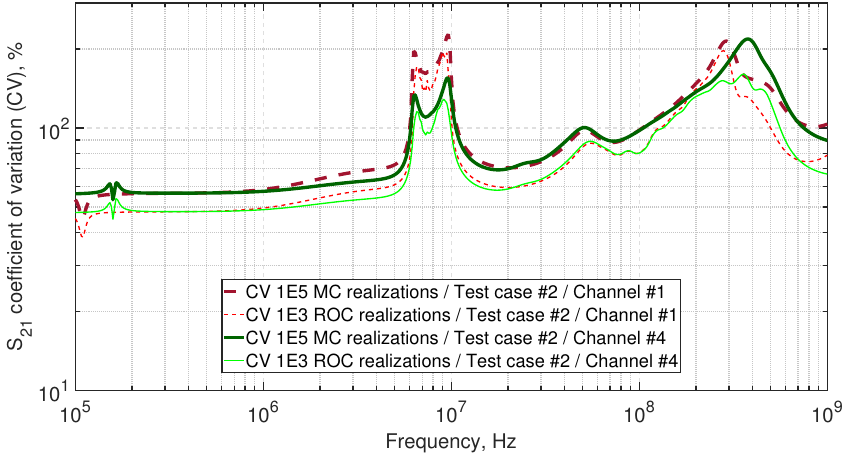
Figure 18. S 21 Test cases #2: CVs from Channel #1 (red curves) and #4 (green